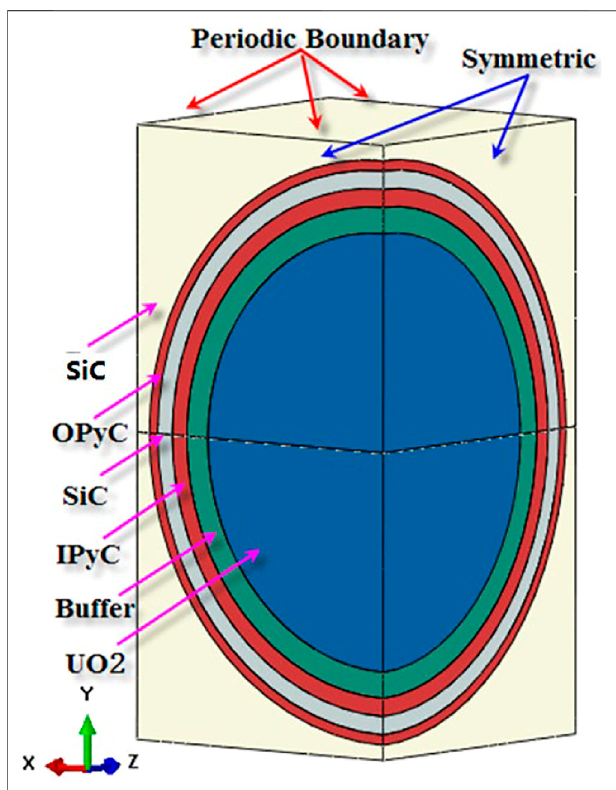
FIGURE 2 | 1/4 representative volume element model of FCM